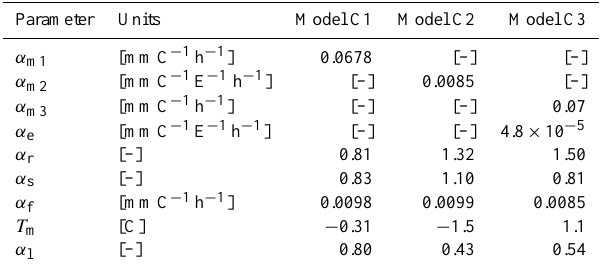
Table 6. Optimal parameter values estimated for the Joe Wright station for models C1, C2 and C3. E is in Wm − 2 .